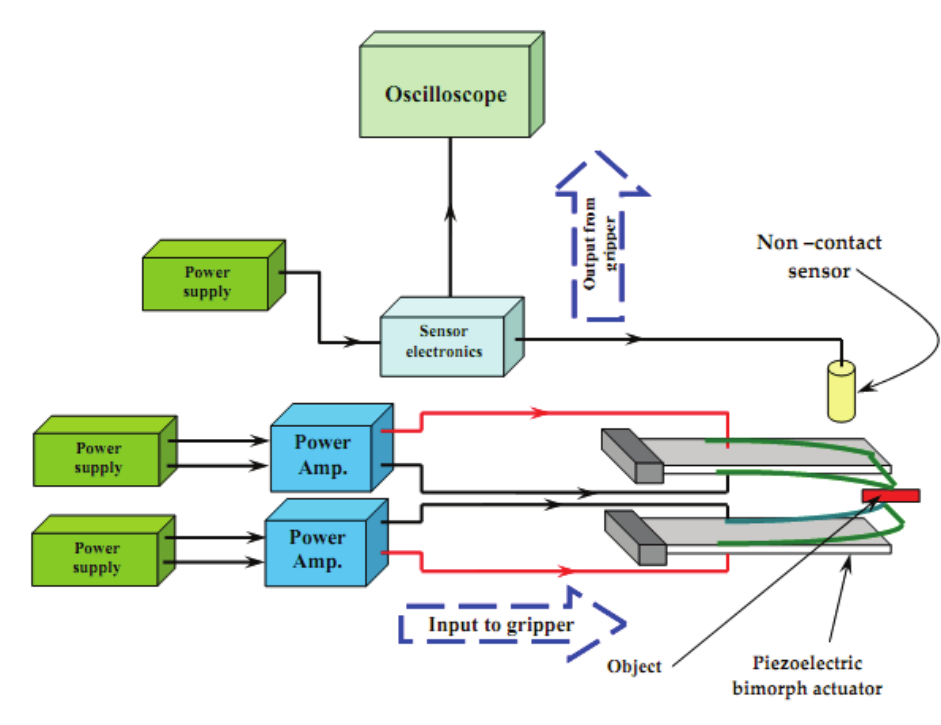
Figure 5. General layout of the developed